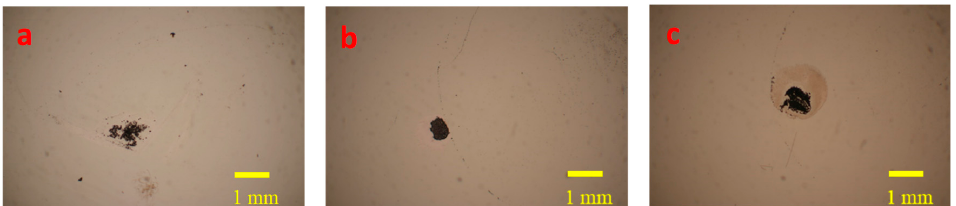
Figure A2. Dried stain images of 100 μ L droplet containing 5 μ m polystyrene microspheres, loaded on the concentration device of this study, evaporated at ( a ) 35 °C for 28 min; ( b ) 40 °C for 20 min; ( c ) 55 °C for 18 min.